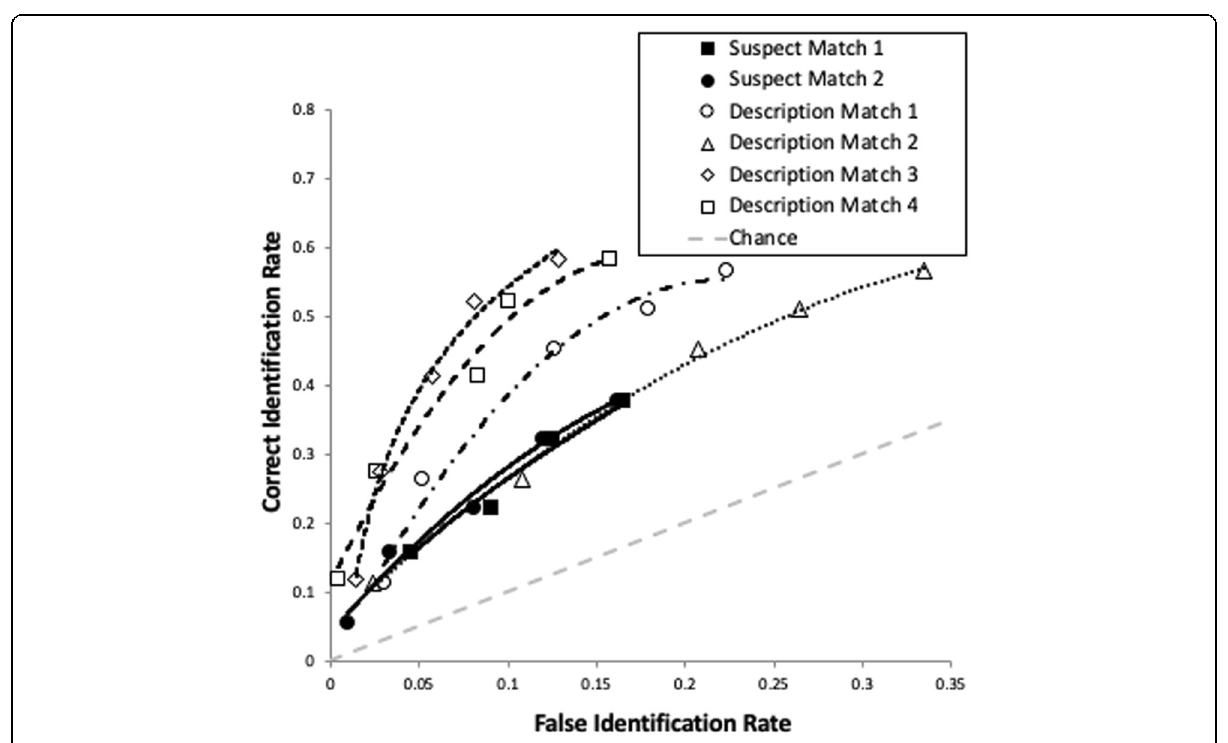
Fig. 4 ROC data (with trendlines) for all description-matched and suspect-matched lineups from Experiment 2